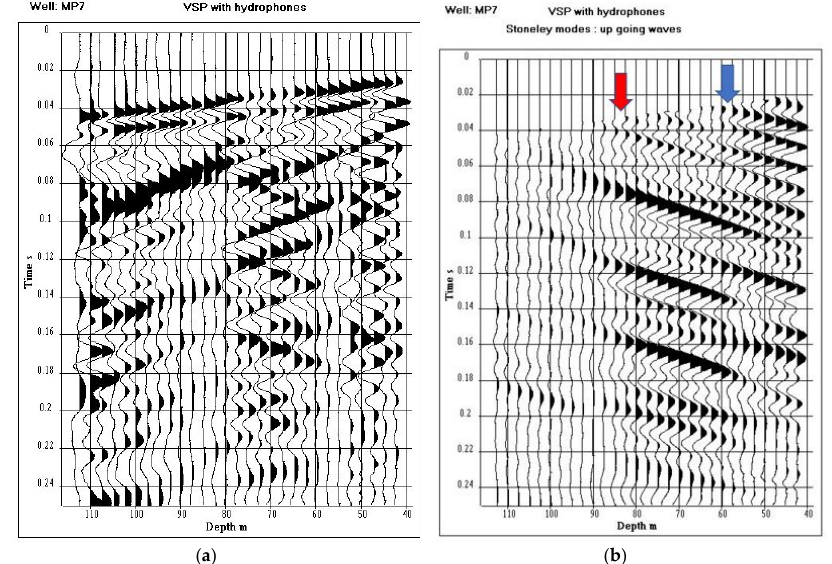
Figure 18. VSP processing. ( a ) VSP after amplitude recovery, ( b ) up-going Stoneley wave. Blue and red arrows indicate the position of karstic bodies detected by acoustic logging.